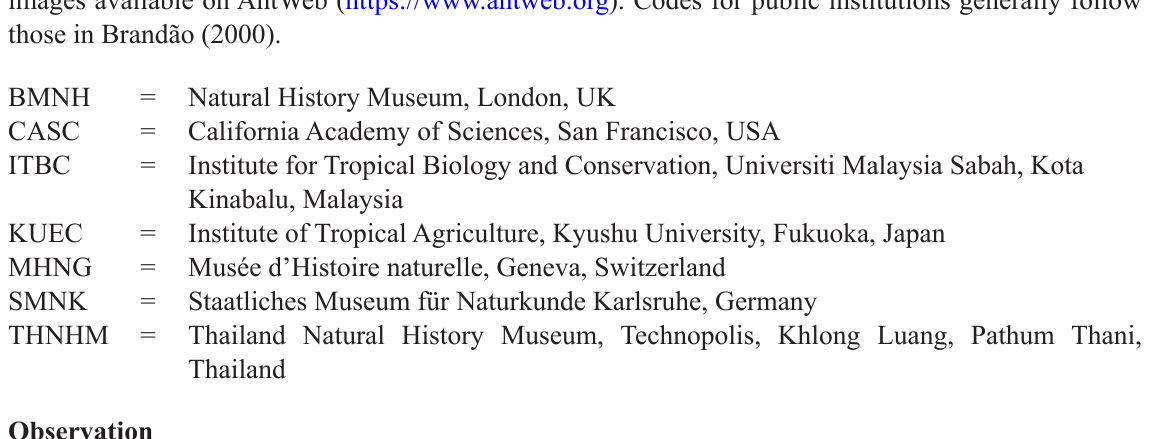
Measurements and